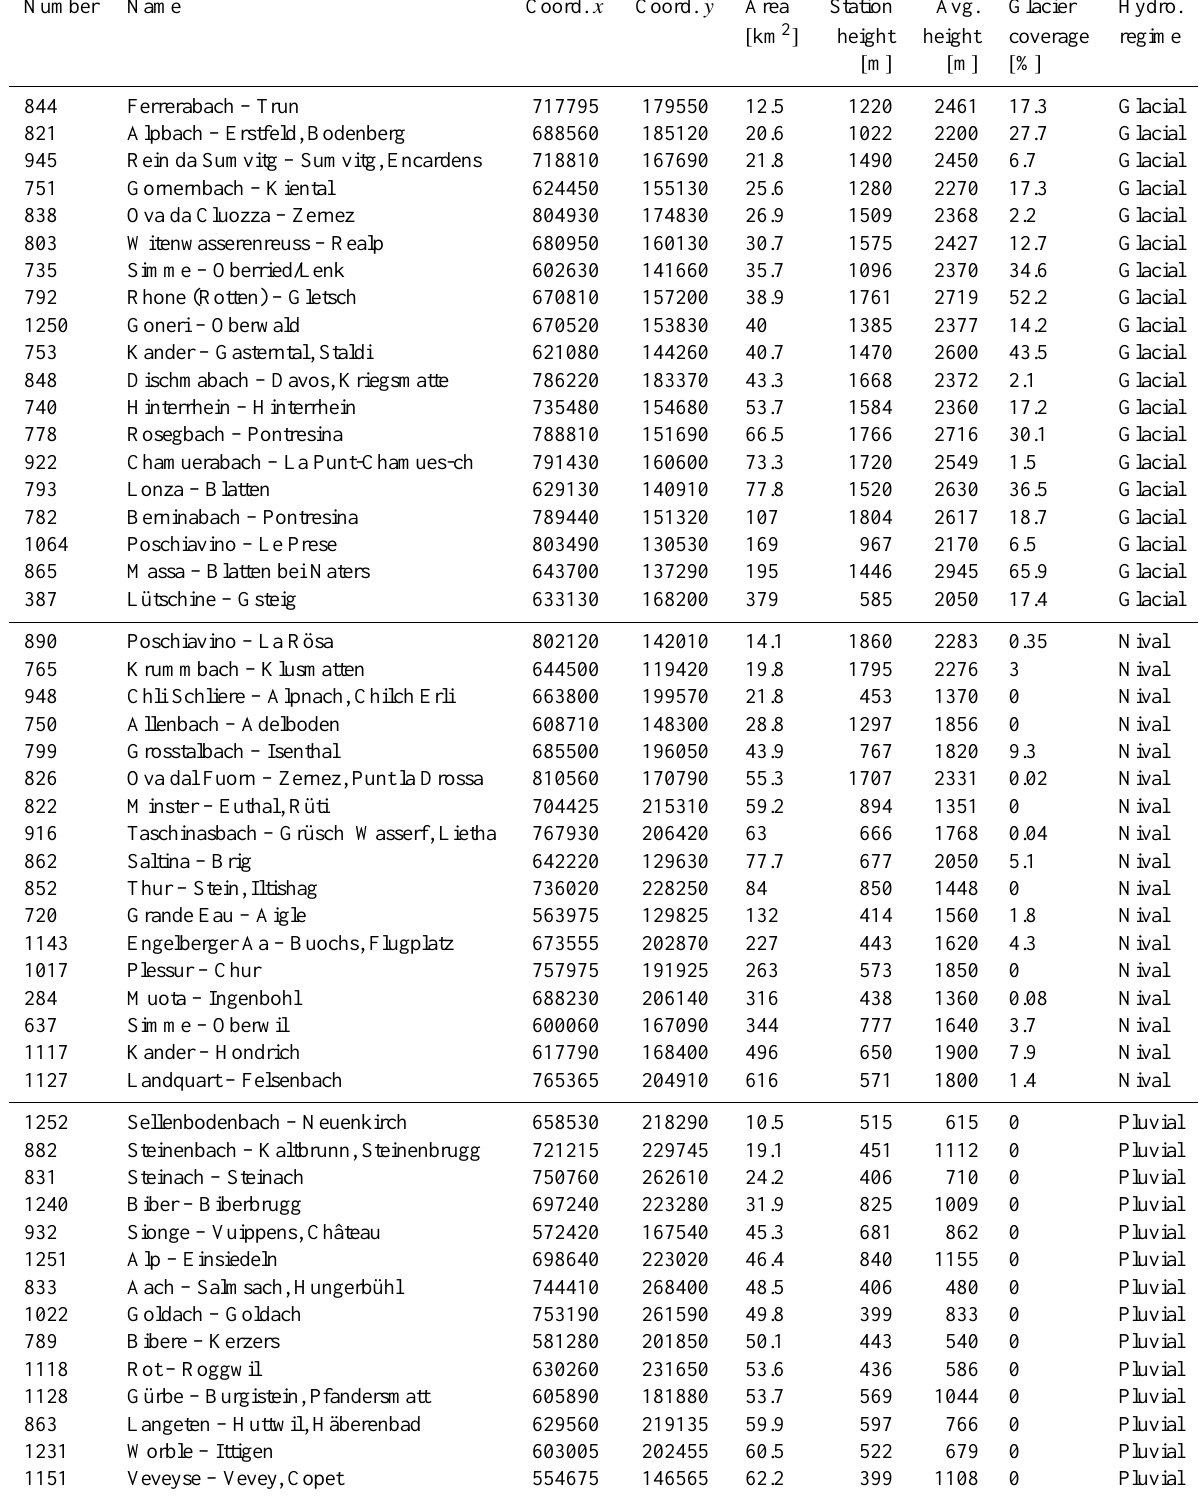
Table 3. Summary of catchment properties for the selected stations. Catchments are sorted based on hydrological regime and increasing size from top to bottom. Locations are given in Swiss coordinates